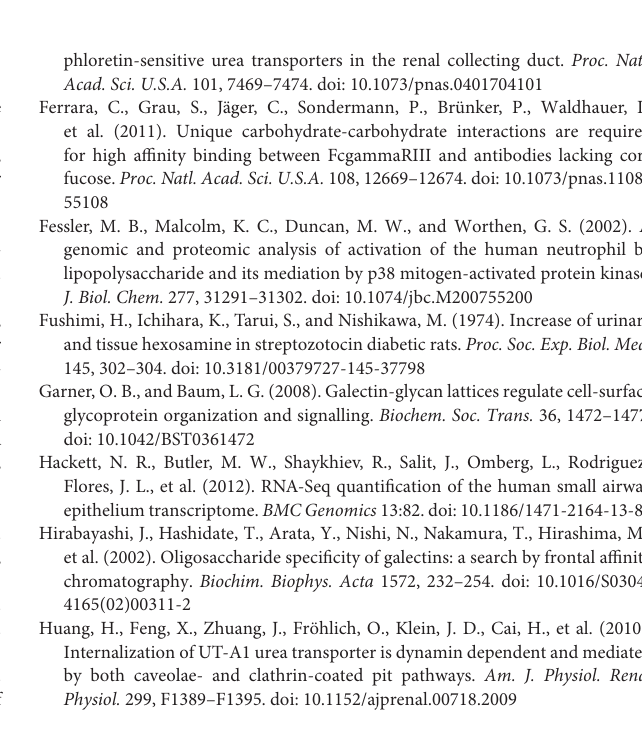
Supplemental Table S1 | Summary of RNA-Seq coverage data. Supplemental Table S2 | Upregulated network list. Supplemental Table S3 | Downregulated network list. Supplemental Table S4 | Primer sequences for qPCR. Supplemental Figure S1 | Volcano plot of the fold change of transcripts in control and STZ rat IM. The x-axis is log 2 fold change and the y-axis is -log 10 p